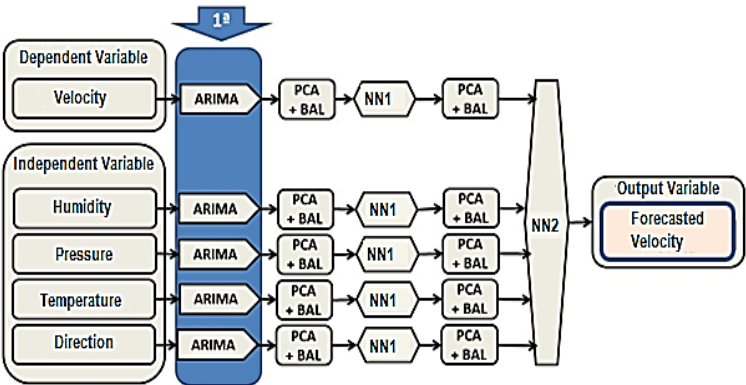
Figure 3. Block diagram of the first stage of the model—ARIMA.